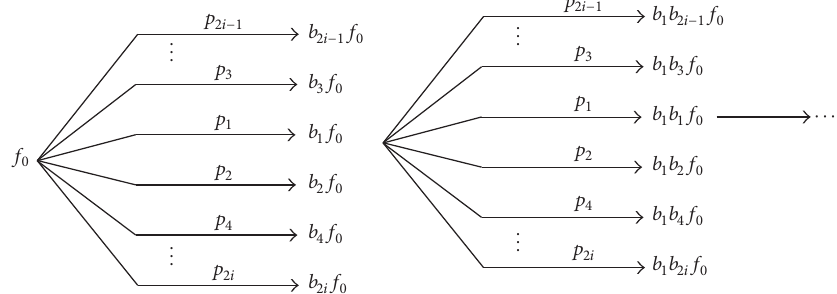
Figure 1: The multinomial tree diagram of the combined multinomial pricing model.